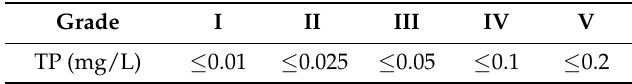
Chinese Water Quality Standards (GB3838-2002) for reservoir total phosphorus (TP) concentrations.